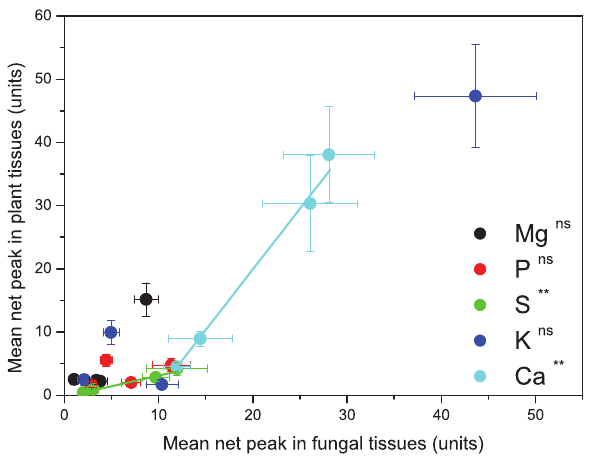
Fig. 5. Relationship between subcellular element concentrations in plant and fungal tissues. ** indicate significant correlations with P , 0.01. ns 5 not significant.